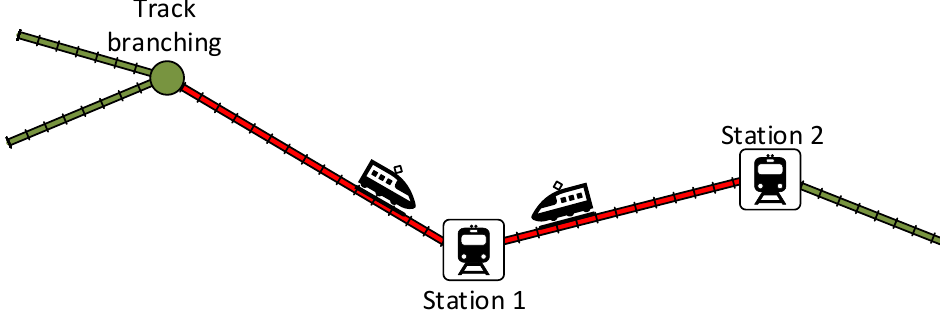
Figure 15. Illustration of detection of two vehicles at two edges.